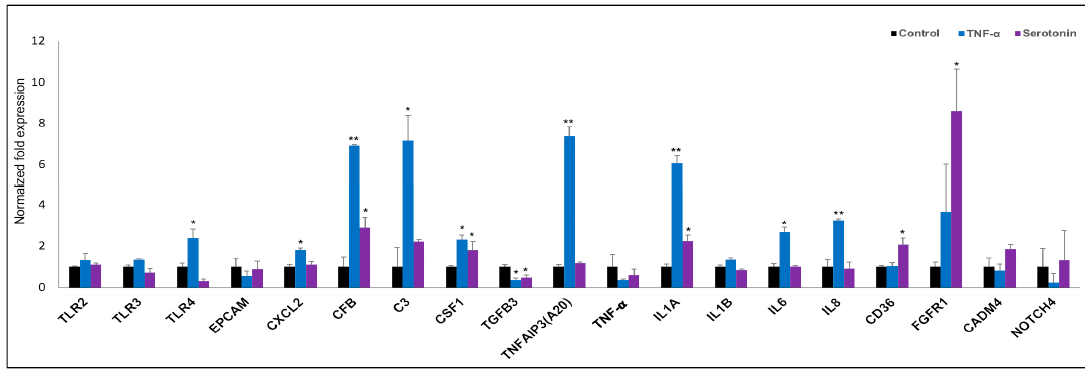
Figure 8. RT-qPCR validation of expression changes of selected immune response-related genes in porcine mature adipocytes (pMA) of intramuscular origin. The pMA (2.5 × 10 4 cm 2 ) were stimulated with serotonin (100 μ M) and TNF- α (2.5 μ g/mL) both for 12 h. The normalized fold expression of each gene obtained from three independent experiments and represented in each bar as mean ± standard deviation. The asterisks (*, p < 0.05; **, p < 0.01) indicate statistically significant difference when compared with control.